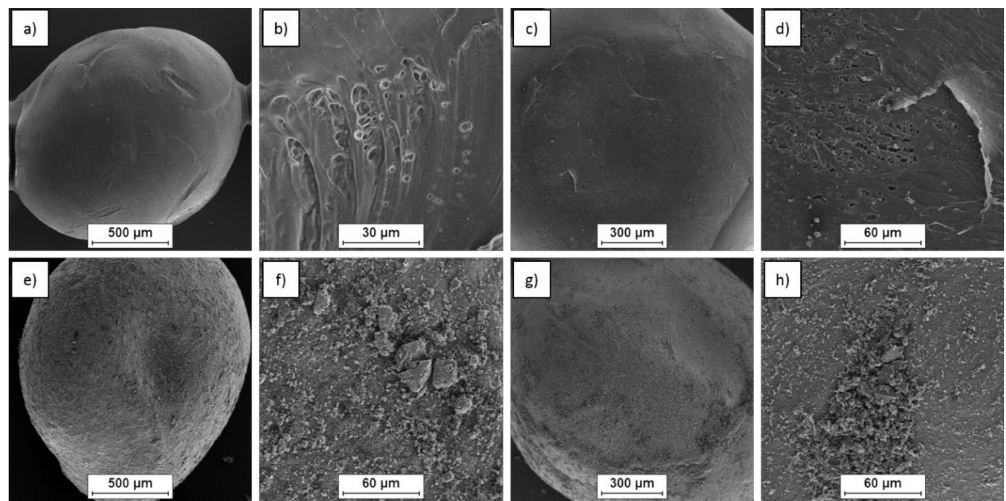
Figure 3. Morphology of PA6 granules: without modification ( a , b ), with graphene oxide (GO) modification ( c , d ), with glassy carbon particles (GC) modification ( e , f ) and with biocarbon (BC) modification ( g , h ).